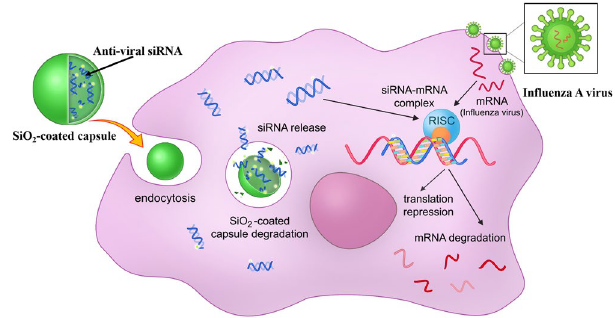
Figure 1. The schematic illustration of the intracellular delivery of antiviral siRNA against influenza A virus using SiO 2 -coated hybrid capsules.